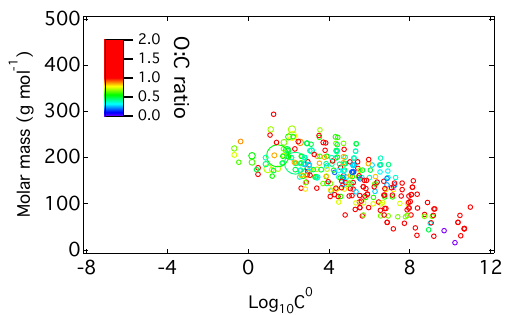
Figure 5. Molar mass vs. the logarithm of the pure components saturation concentration for the compounds included in the APIN and propene MCMv3.2 degradation scheme. The size of the circles is proportional to the compound mass in the aerosol phase found in APIN-lNO x